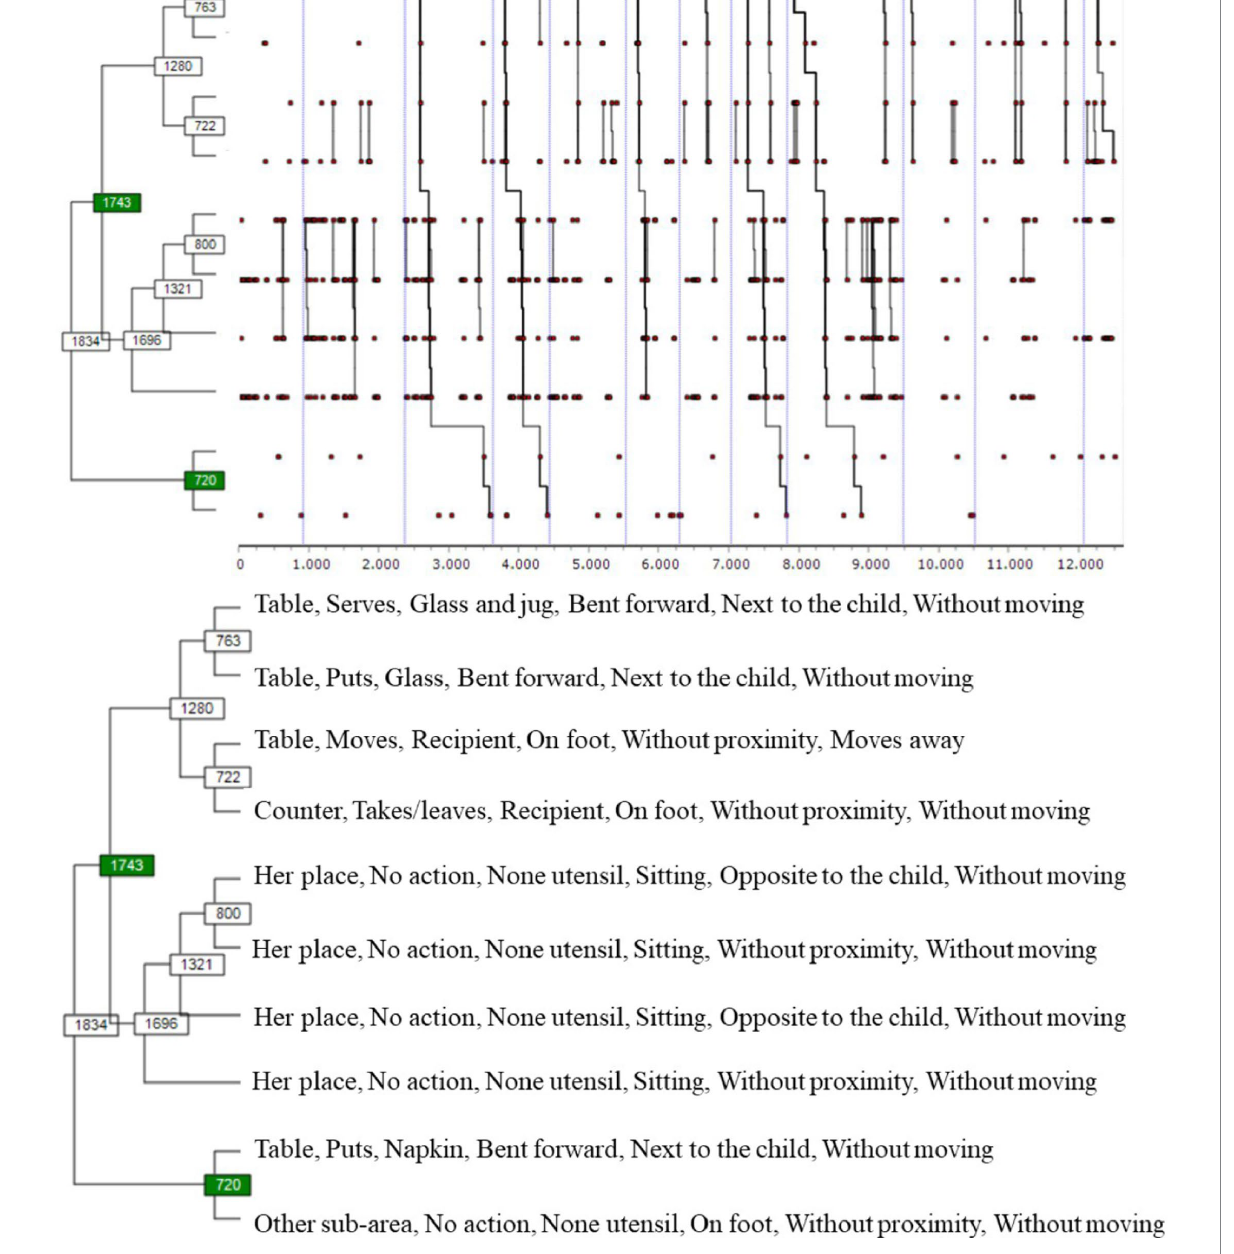
FIGURE 3 T-pattern Educator-2 ʼ s behavior obtained with